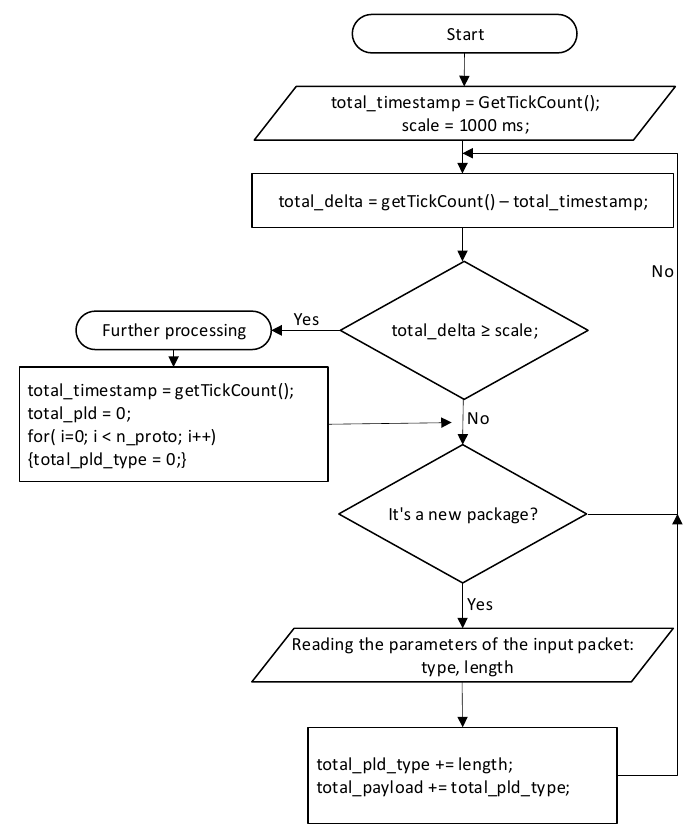
Figure 18. Algorithm for determining the load of information flows.